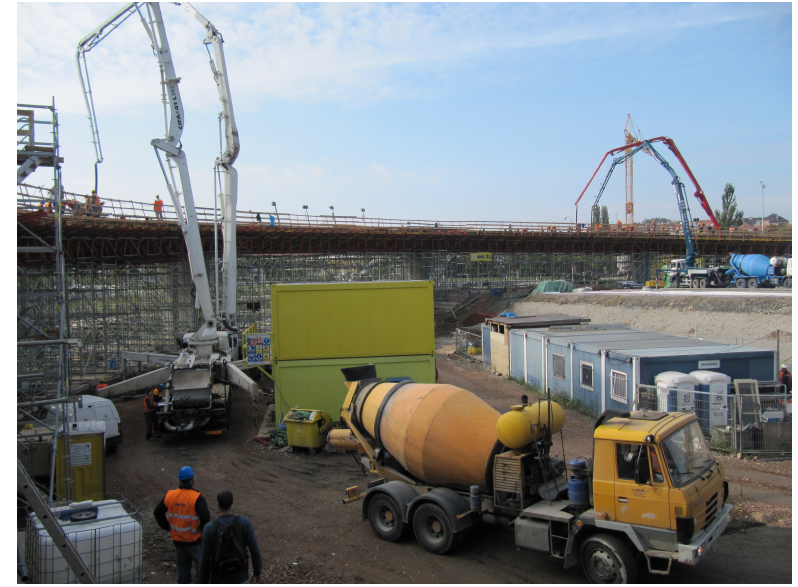
Figure 1. Bridge construction during which concrete C 30/37 XF4 was sampled. Table 1. Composition of concrete C 30/37